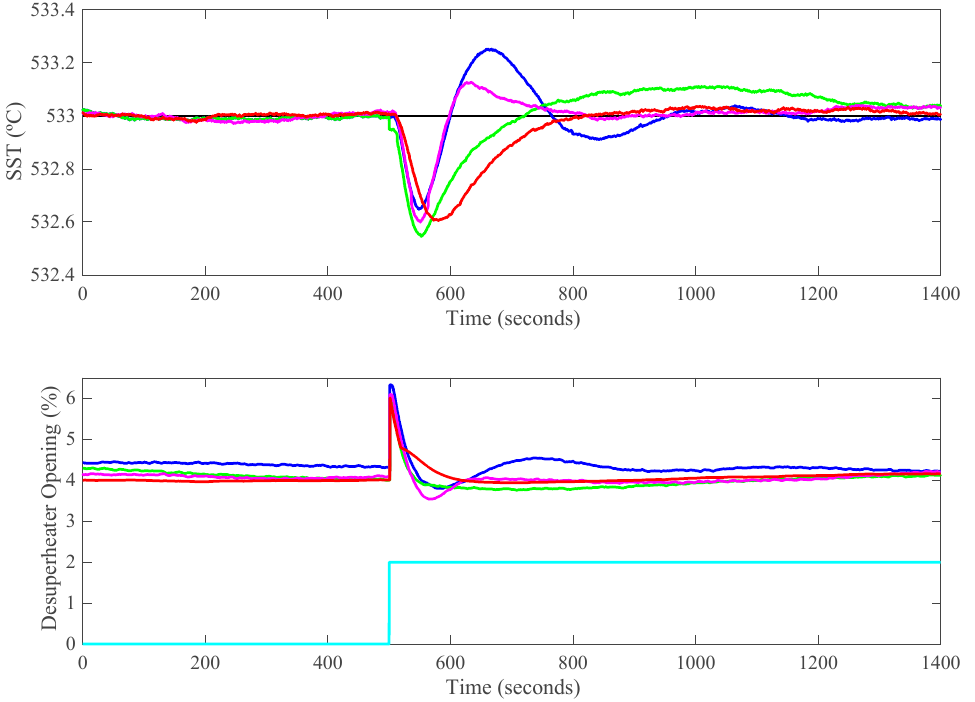
Figure 22. Experimental results of disturbance rejection on the power plant simulator. (Set point: — ,